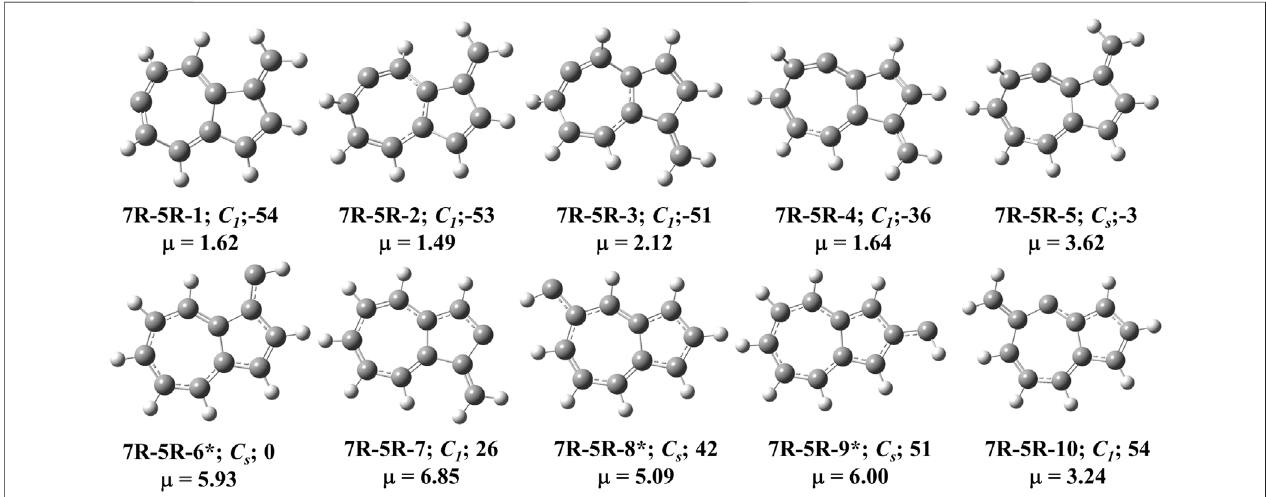
FIGURE 5 | First ten low-lying C 11 H 8 carbenes/cyclic allenes isomers of (7R-5R) group. ZPVE-corrected relative energies (in kJ mol − 1 ), absolute dipole moment values (in Debye) are calculated at the B3LYP/6-311 + G (d,p) level of theory. Experimentally detected isomers are marked with an asterisk symbol.